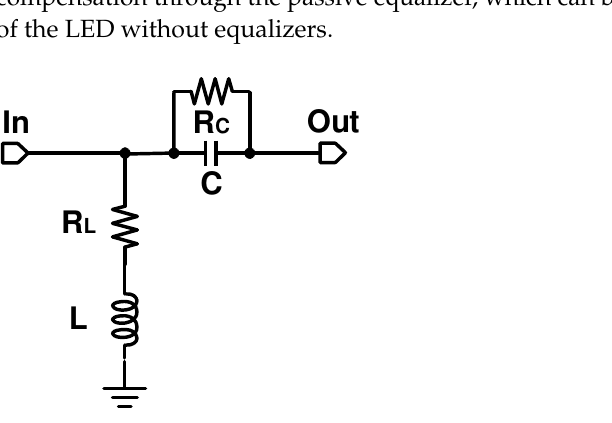
Figure 6. Schematic of the adopted passive equalizer.